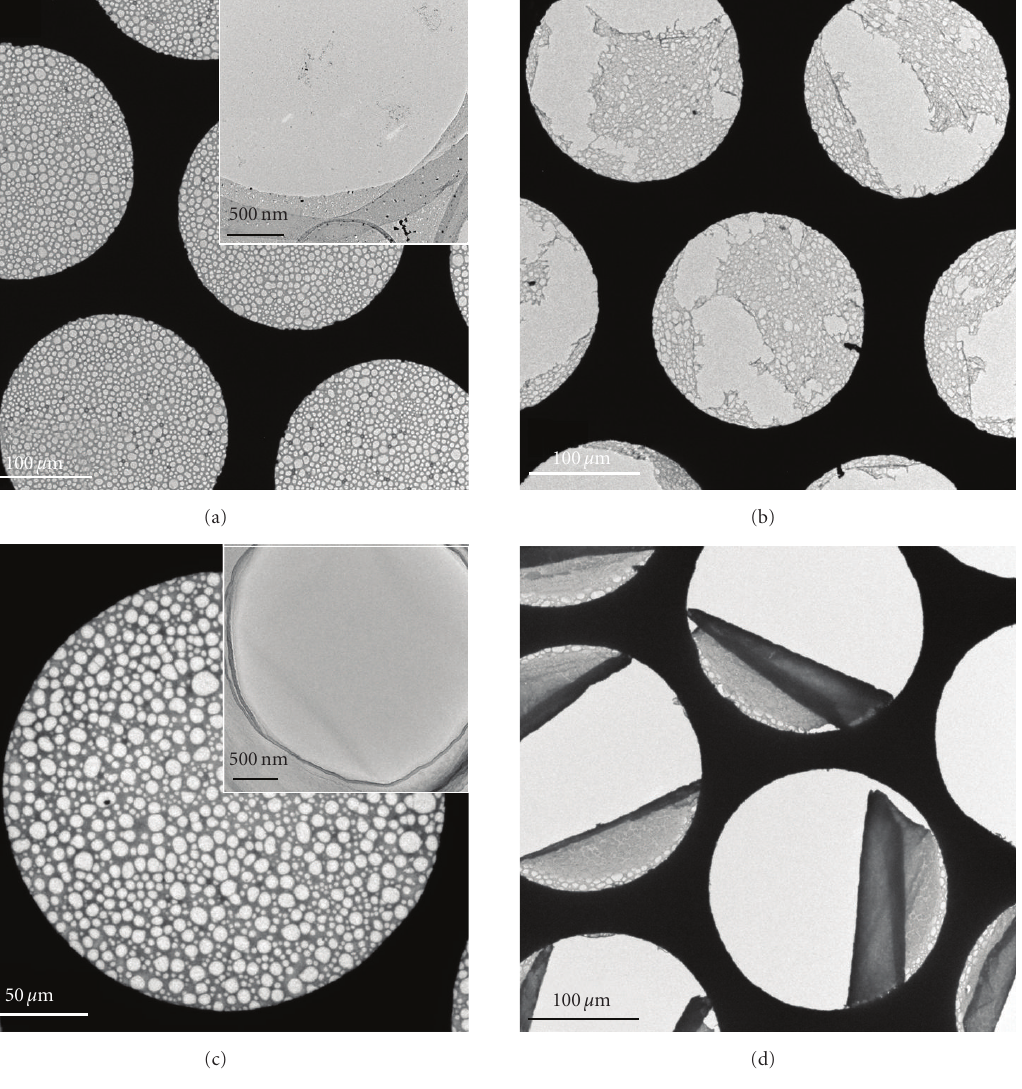
Figure 2: Low magnification TEM images of ALD-Al 2 O 3 films with 2nm thickness heated at (a) 600 ◦ C in air, (b) 700 ◦ C in air, (c) 900 ◦ C in vacuum, and (d) 985 ◦ C in vacuum. The insets in (a) and (c) are enlarged TEM images of the Al 2 O 3 film over a hole of holey carbon